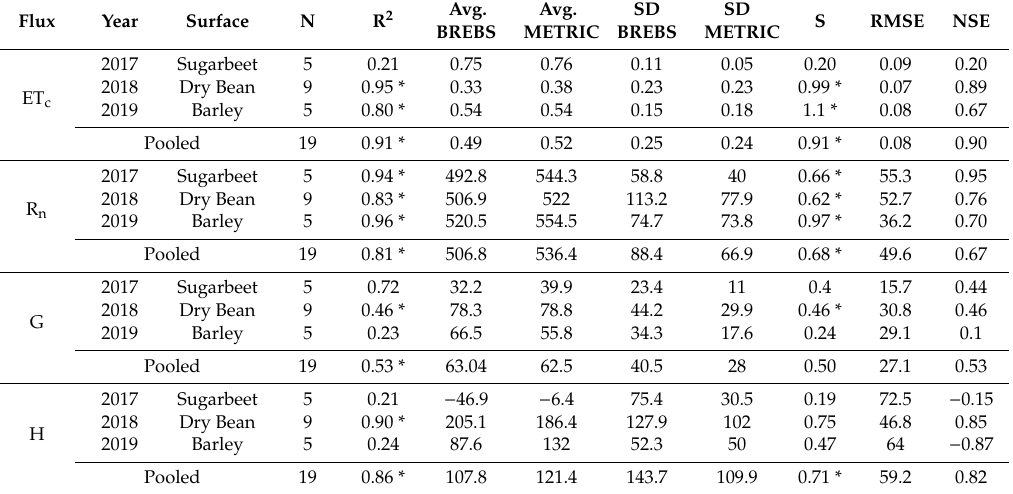
Figure 6. METRIC—estimated and BREBS—measured instantaneous surface energy balance fluxes ( a ) crop evapotranspiration (ETc), ( b ) net radiation (Rn), ( c ) sensible heat (H), and ( d ) soil heat (G) for 2017, 2018, and 2019 growing season as well as a combined pooled data at the BREBS flux-tower footprint located in Powell Research and Extension Center, Powell, WY, USA. Table 2. Statistical comparison between METRIC estimated and BREBS measured crop evapotranspiration (ET c , mm h − 1 ), net radiation (R n , Wm − 2 ), soil heat (G, Wm − 2 ), and sensible heat (H, Wm − 2 ) for 2017, 2018, 2019, and pooled data from all the growing seasons (N = number of data points, R 2 = coe ffi cient of determination, SD = standard deviation, S = slope, RMSE = root mean square error, NSE = Nash-Sutcli ff e’s e ffi